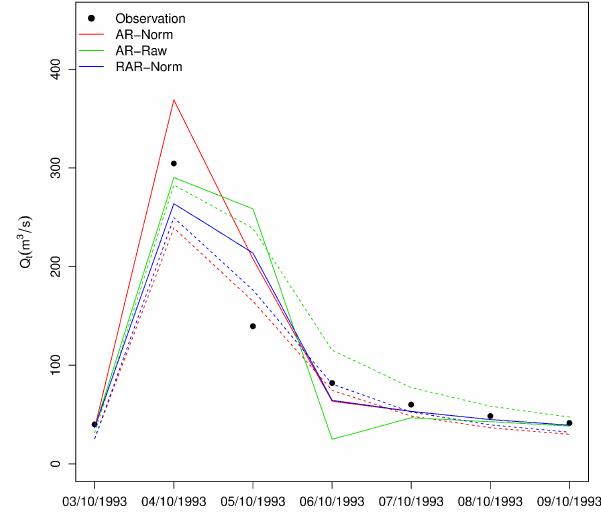
Figure 5. An example of over-correction caused by the AR-Raw model in the Mitta Mitta catchment. Dashed lines: forecasts from the base hydrological model (i.e. without error updating). Solid lines: forecasts with error